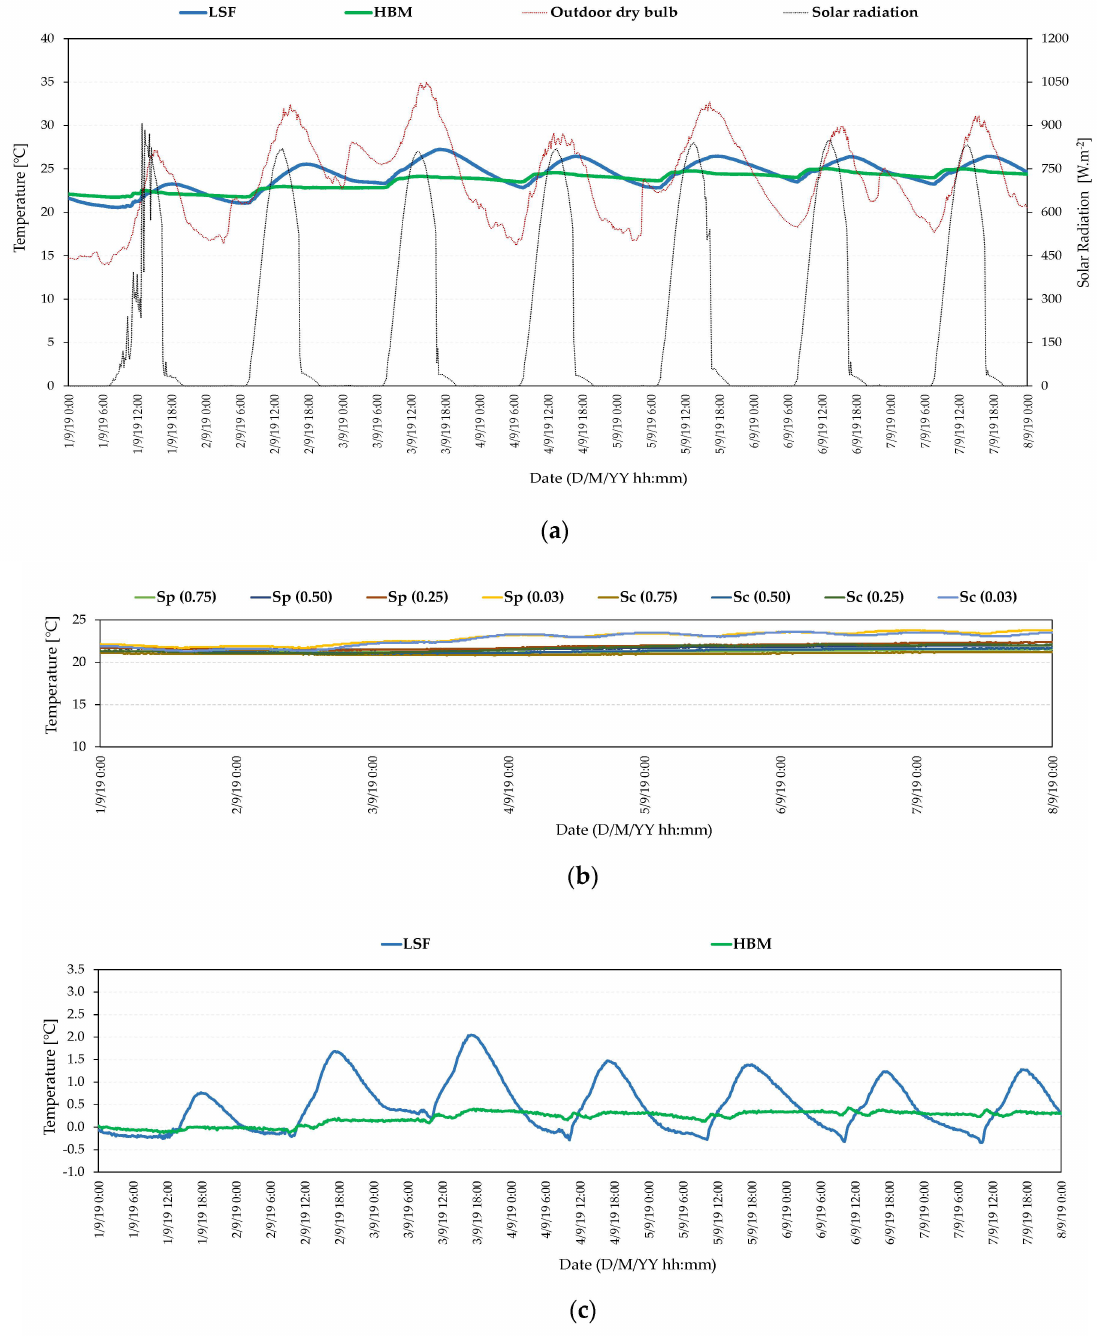
Figure 5. Summer week analysis: ( a ) indoor air temperatures in the experimental test cells and outdoor environmental conditions; ( b ) soil temperatures at different depths and locations; ( c ) indoor air temperature vertical stratification between the inferior and superior monitoring